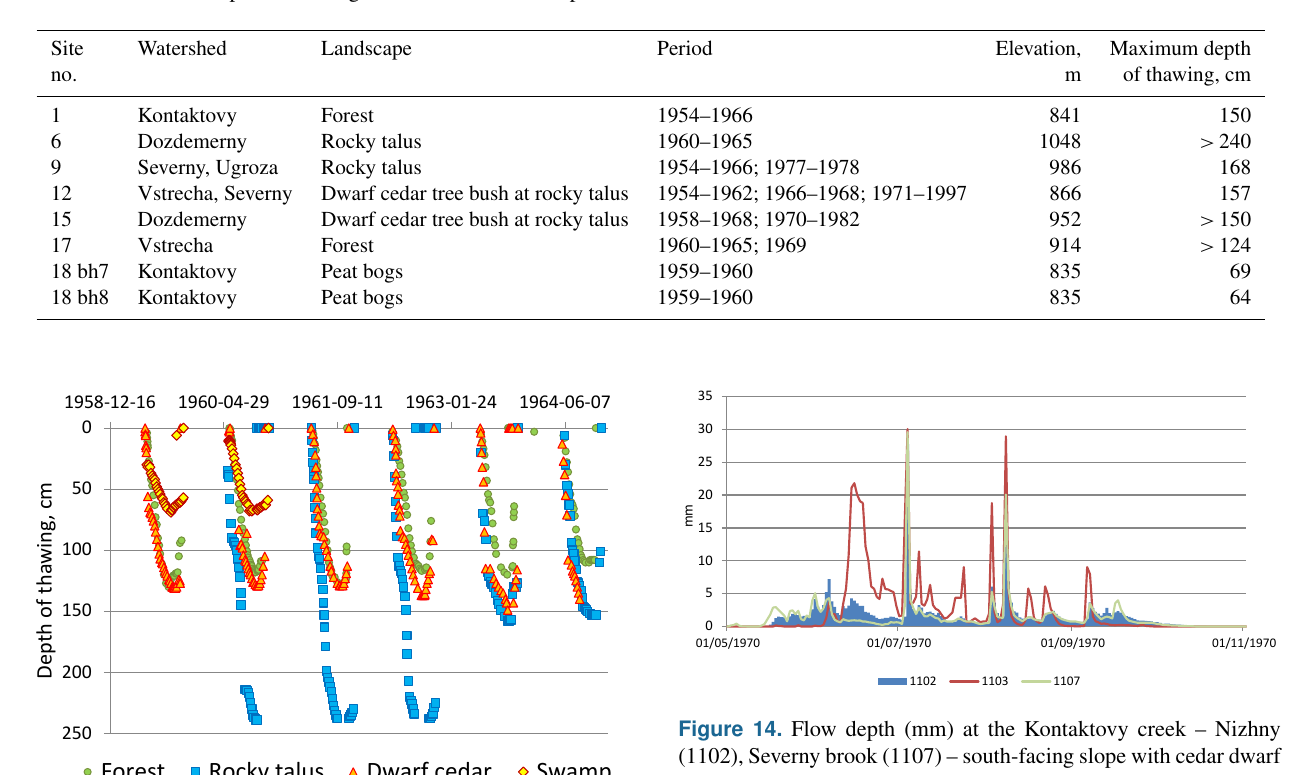
Table 6. Maximum depth of thawing at the different landscapes.